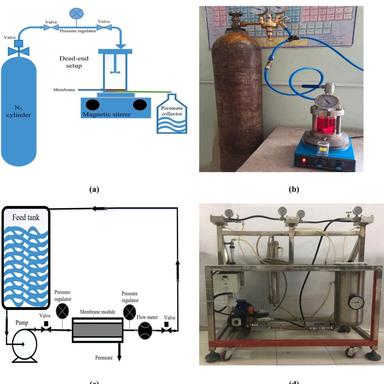
Schematic and photographs of the: (a and b) dead-end set-up and (c and d) cross-flow set-up.